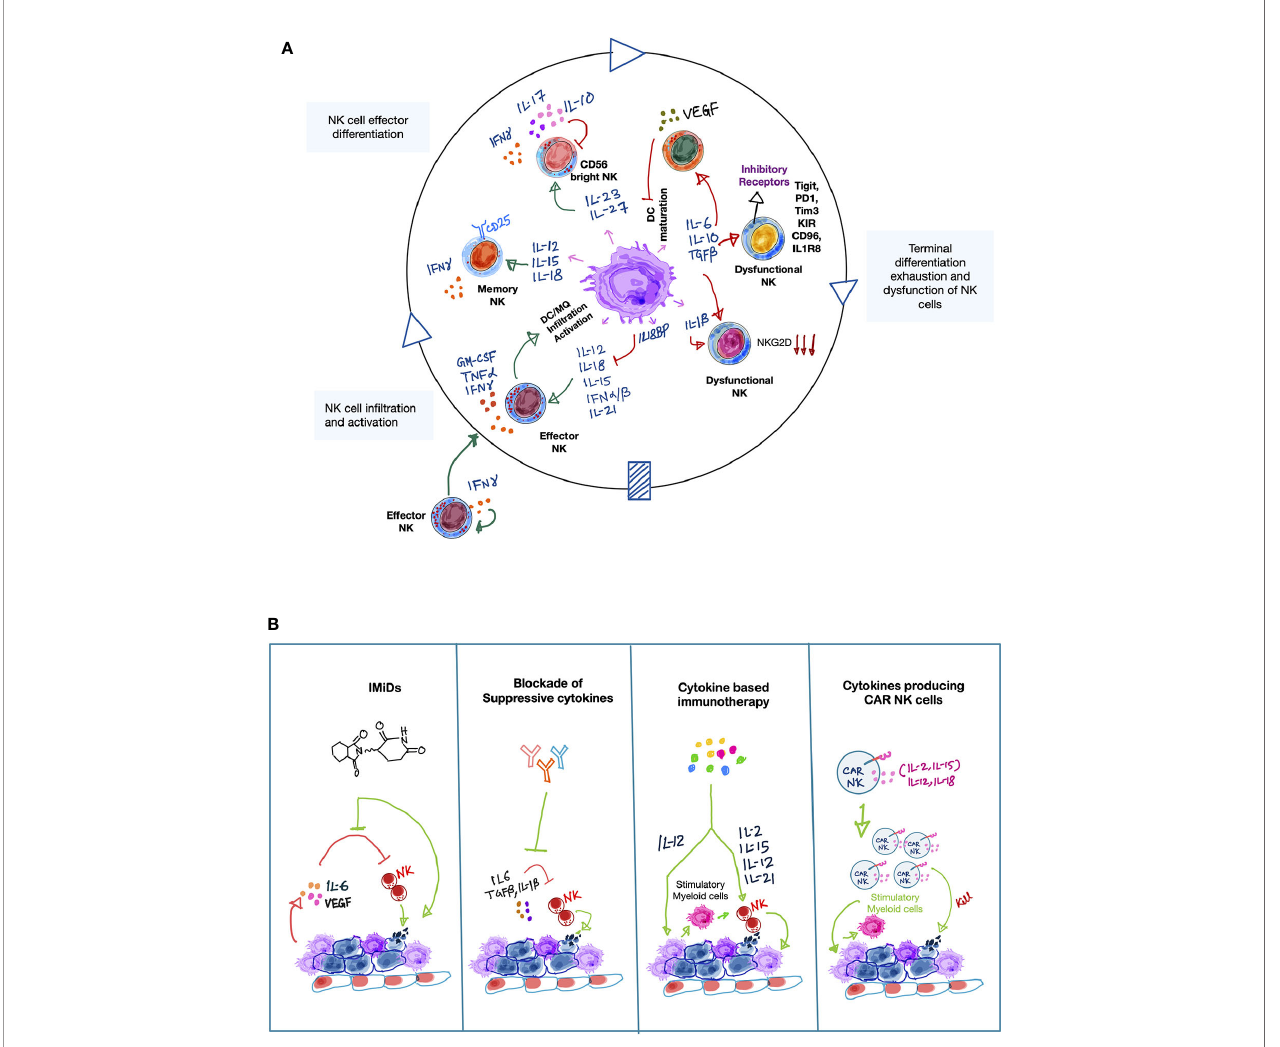
FIGURE 1 | Cytokines involved in the NK-myeloid cell cross talk in the tumor microenvironment. (A) A simpli fi ed schematic illustration showing the orchestra of myeloid- and NK cell-derived cytokines involved in forming anti-tumor immune responses by NK cells in the tumor microenvironment (TME). Activated NK cells produce IFN- g which indirectly promotes recruitment of other NK cells from peripheral blood to the tumor sites. Upon recognition of tumor antigens, myeloid cells, especially DCs and macrophages produce in fl ammatory cytokines such as type-1 IFNs, IL-12, IL-15, IL-18, IL-21. These cytokines either alone or cooperatively promote NK cell survival, proliferation, maturation and production of spectrum of pro-in fl ammatory cytokines, including IFN- g , TNF- a , GM-CSF, which further boost anti-tumor immune-activating potential of myeloid cells while recruiting additional in fl ammatory myeloid cells [including M1 macrophages (MQ), mature dendritic cells (DCs)] to sustain the anti-tumor immune response. Furthermore, myeloid-derived IL-23 and IL-27 cytokines can also promote NK cell activity by inducing IFN- g production, but they can also negatively in fl uence the NK-myeloid cell anti-tumor crosstalk by secretion of tumor-promoting cytokines such as IL-17 and IL-10, respectively. This suggests a dual role of IL-23 and IL-27 in NK cell-mediated tumor immunity. In line with the dual roles of certain cytokines, myeloid cells can become immune suppressive (myeloid-derived suppressor cells; MDSCs). This is frequently occurring during cancer progression. MDSCs secrete a plethora of immune suppressive cytokines that negatively in fl uence the anti-tumor potential of NK cells per se but also impair anti-tumor responses normally resulting from the NK-myeloid cell crosstalk. For example, suppressive cytokines promote NK cell exhaustion and directly impair NK cell-mediated cytolytic activity, while limiting the ability of myeloid cells to produce NK cell stimulatory cytokines such as IL-12, IL-15, and IL-18. Green arrows indicate positive interactions and red arrows indicate negative interactions. (B) Therapeutic approaches that directly or indirectly modulate cytokine mediators that enhance NK cell-mediated anti-cancer responses in the TME. Simpli fi ed illustrations showing validated therapeutic approaches that can either restore or reinforce a stimulatory cytokine environment to augment NK cell- mediated tumor killing activity. On one hand, immunomodulatory drugs (IMiDs) such as lenalidomide can indirectly augment NK cell anti-tumor activity by reducing the levels of pro-tumorigenic factors, such as IL-6 and VEGF, while stimulating other immune cells to secrete IL-2. Accordingly, targeted blockade of immune- suppressive cytokines, such as IL-6, TGF- b can also positively impact NK-myeloid anti-tumor cross-talk in a similar manner. On the other hand, recombinant or synthetic cytokines as well as cell-based therapies such as cytokine-secreting CAR-NK cells can directly in fl uence NK cell-mediated cancer cell killing. Importantly, cytokine-activated NK cells can further edit myeloid cells to enhance anti-tumor response via the production of in fl ammatory cytokines, such as IFN- g . Light green arrows show the mode of therapeutic